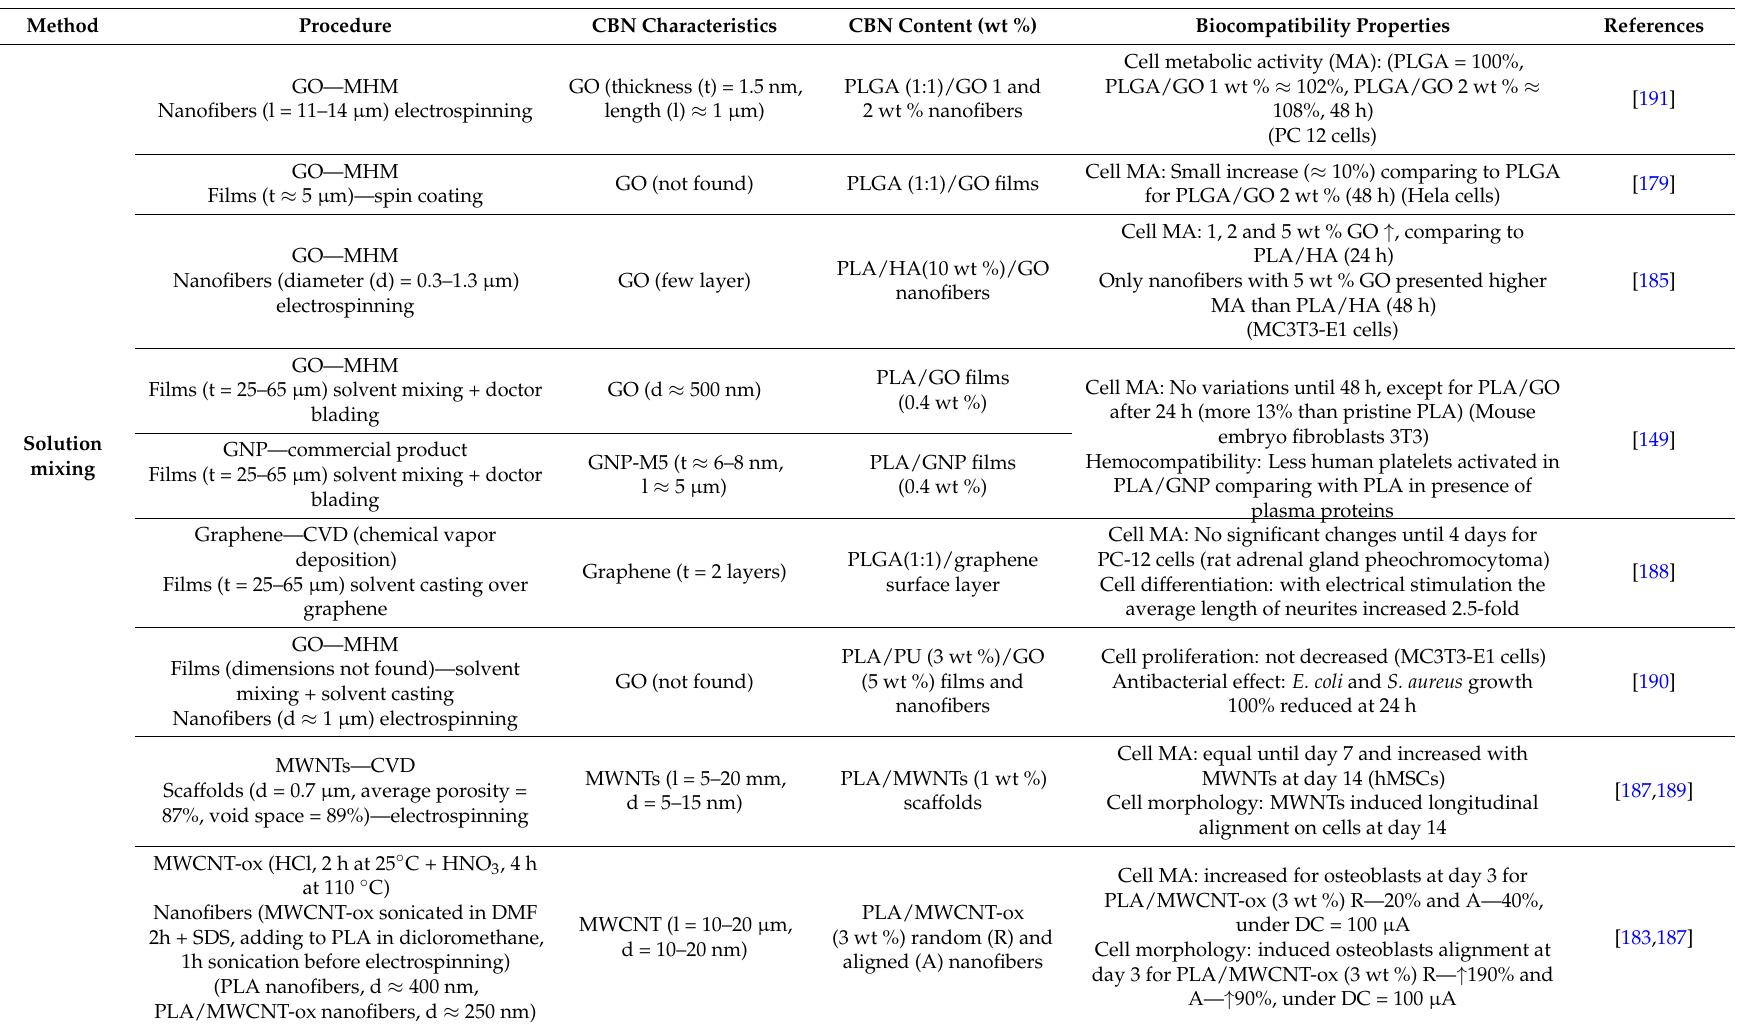
Table 4. Biological properties of PLA/CBN composites in comparison with non-modified PLA. Production methods and CBN